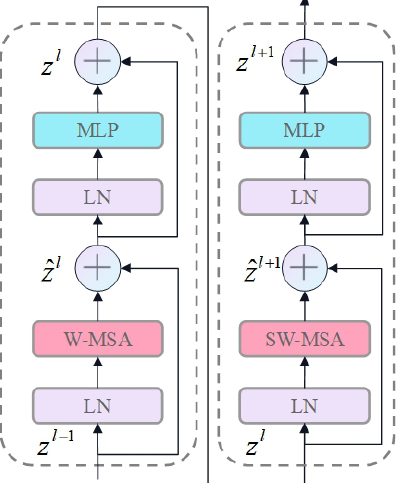
Figure 6. Swin-Transformer block structure.